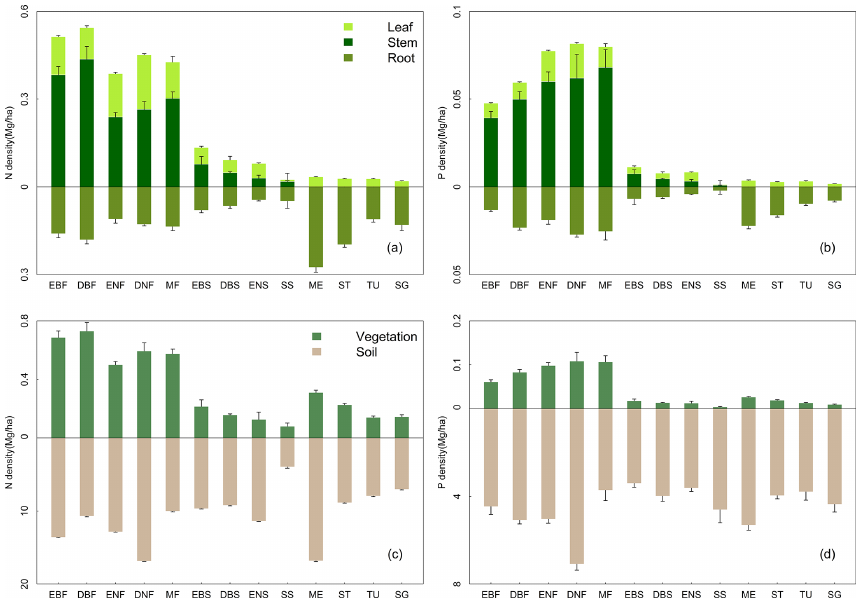
Table 1. N and P stocks of vegetation, litter, soil, and total ecosystem in forests, shrublands, and grasslands in China. Vegetation Vegetation Area